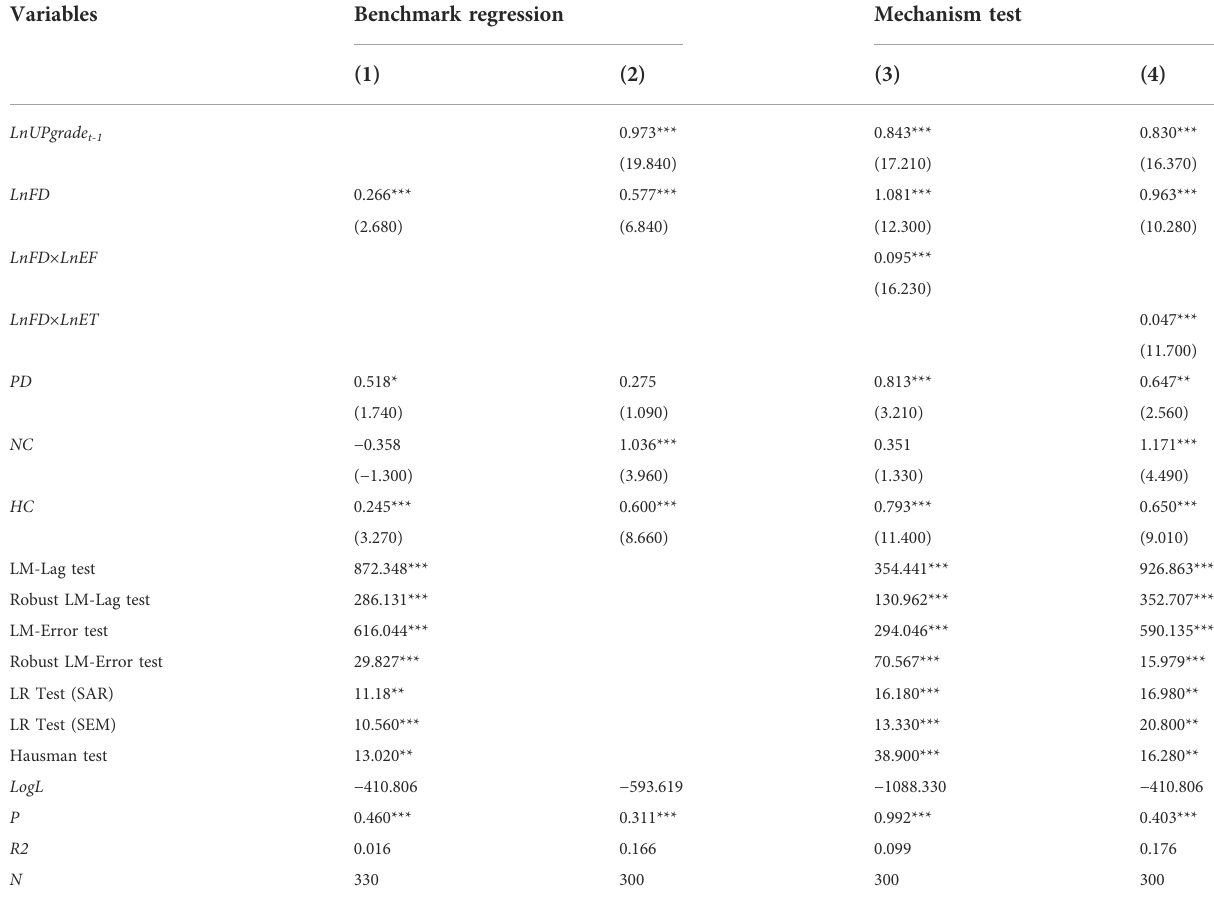
TABLE 7 Estimation results of spatial Durbin